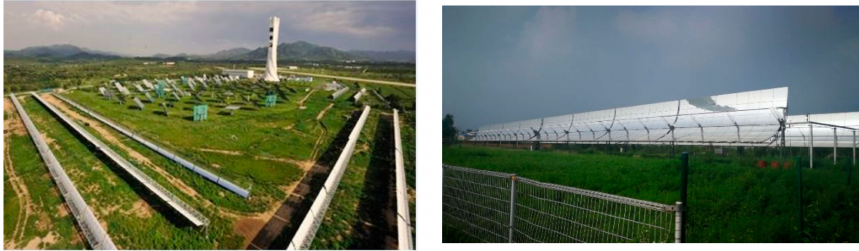
Figure 1. View of the Badaling parabolic trough solar power pilot plant.